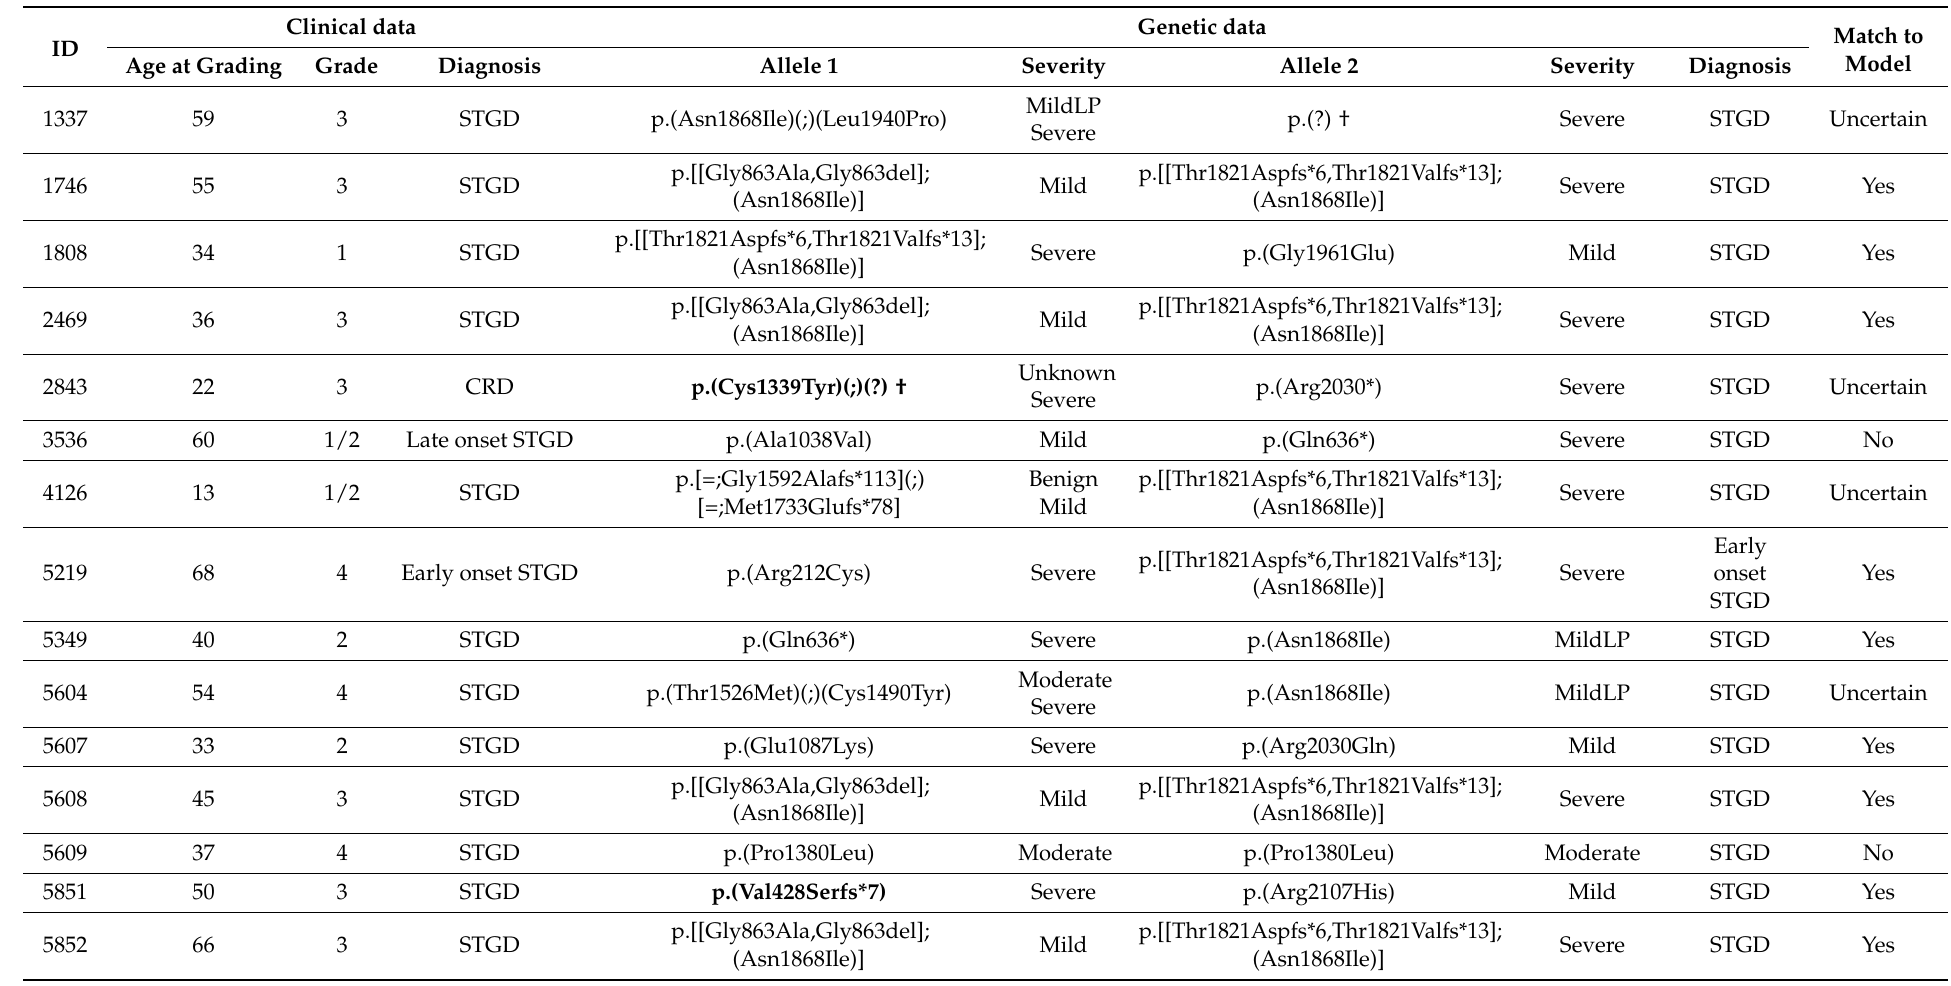
Table 2. Genotype–phenotype correlation for ABCA4 associated disease. Grading and model comparison from Cremers et al., 2020. Identified alleles are reported in protein notation, novel alleles are in bold text. Severity score for the variants was obtained from Cornelis et al., 2022. In “Diagnosis” columns, when not otherwise specified, STGD refers to intermediate/classical Stargardt